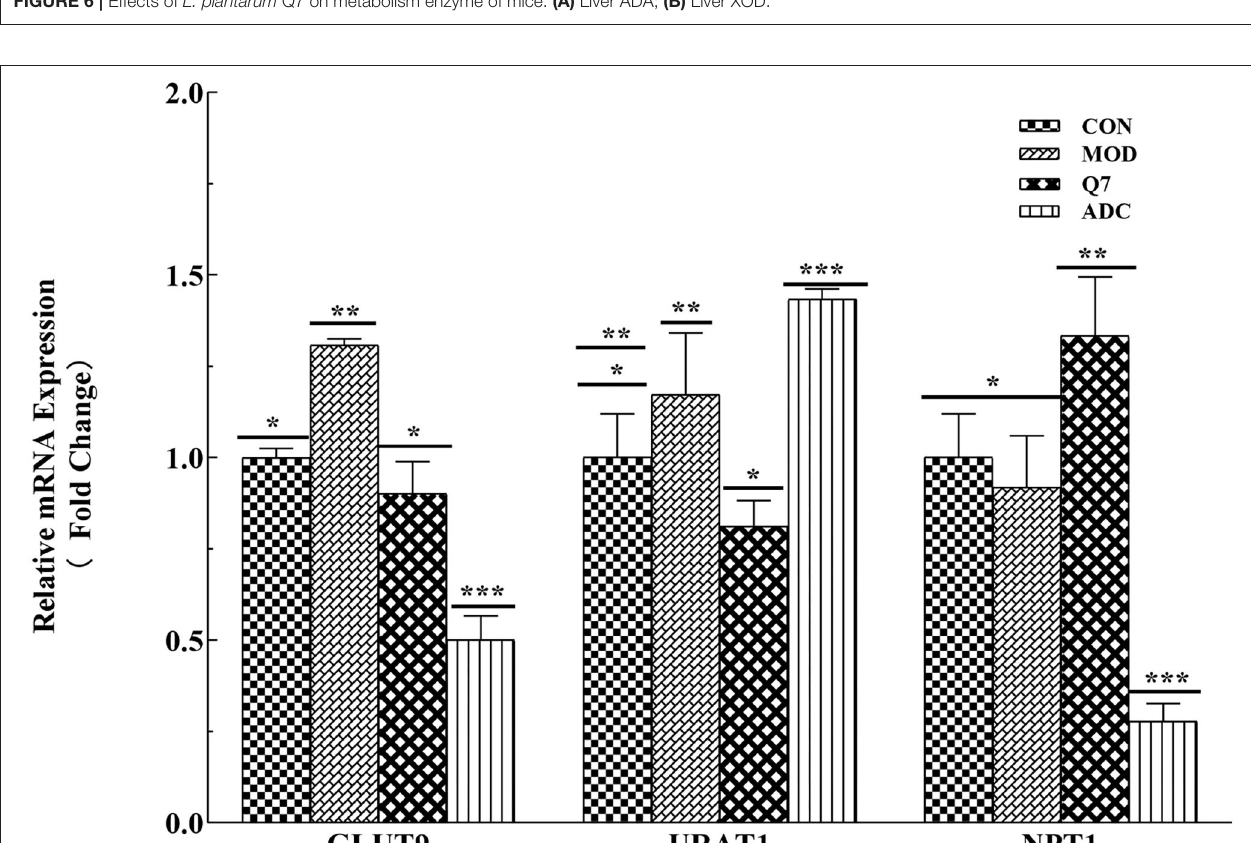
FIGURE 7 | Effects of L. plantarum Q7 on the transporter expression level of mice.